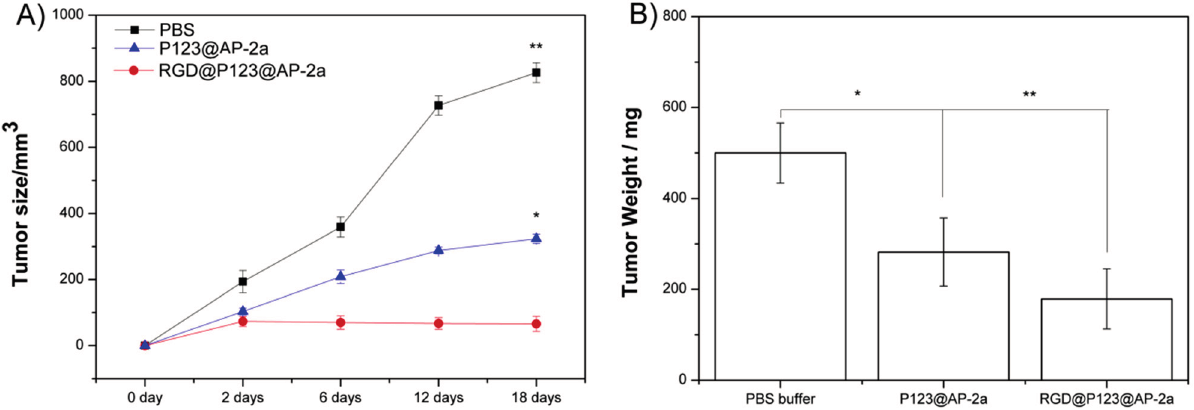
Figure 4. Detection of gastric tumor ( A ) size and ( B ) weight of nude mice under treating with PBS buffer, P123 and RGD@P123@AP-2 α nanocomposites, respectively. * p < 0.05, ** p <